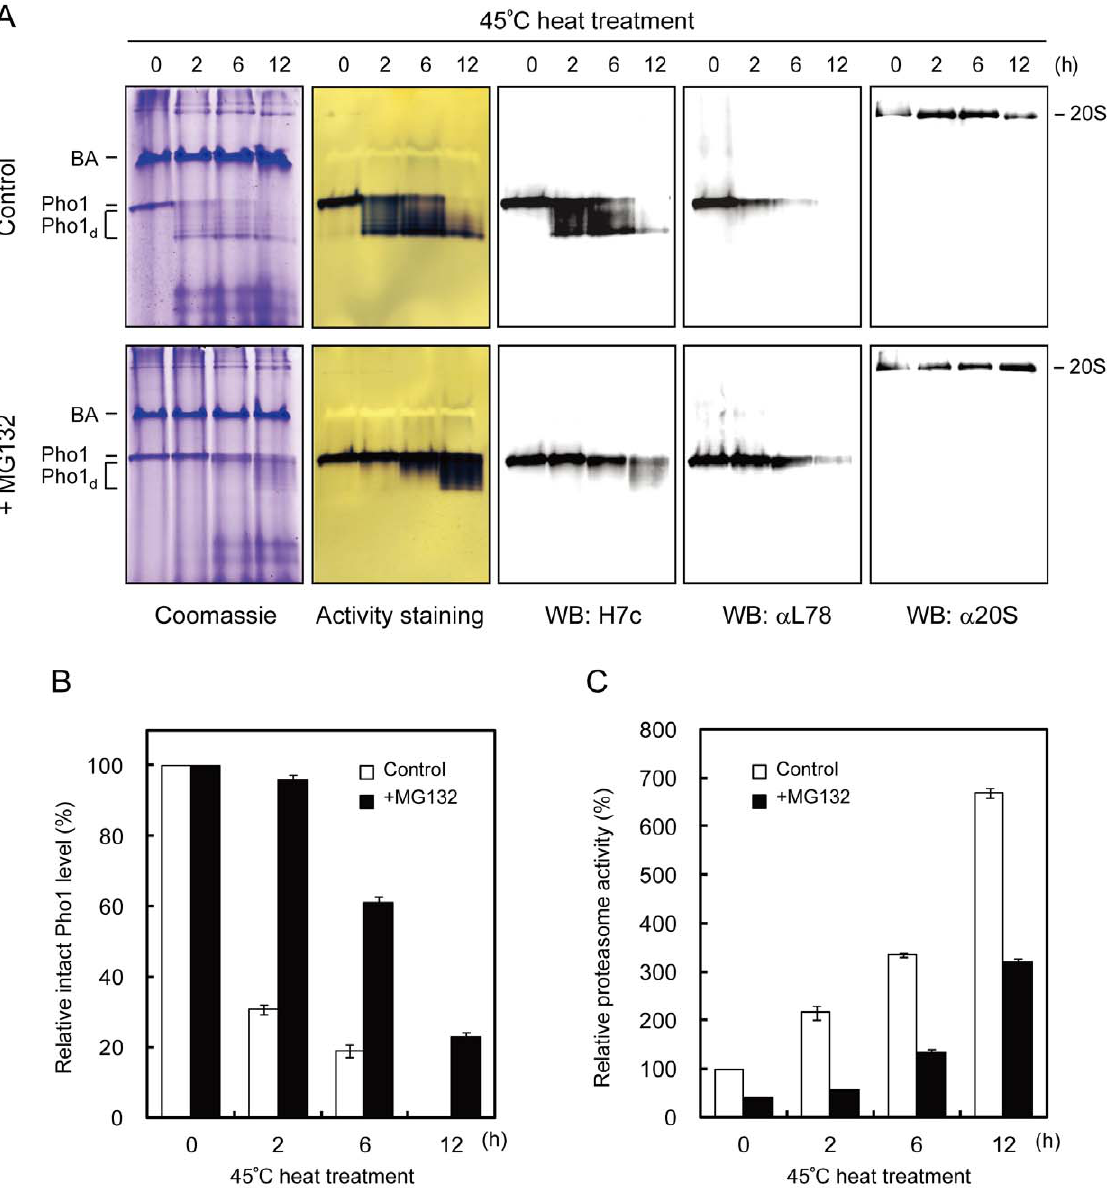
Figure 5. Heat treatment triggered the proteolytic modification of Pho1 by the 20S proteasome. In two parallel experiments sweet potato root discs (0.5 mm thick) were pretreated without (Control) or with 100 m M of MG132 ( + MG132), and then incubated at 45 u C for the indicated time periods. BA, beta amylase; Pho1, intact Pho1; Pho1 d , proteolytic modified Pho1. ( A ) The crude protein extracts of the discs (10 m g) were separated by 7.5% native PAGE and analyzed by Coomassie staining, Pho1 activity staining or western blotting with H7c, a L78 or a 20S antibody, respectively. Data are representative of three independent experiments. ( B ) Quantitative densitometry of the protein levels of intact Pho1 on the western blots detected by a L78 antibody in Figure 5A. The intact Pho1 level of the sample pretreated without (Control) or with MG132 ( + MG132) at time zero was expressed as 100%. Values are means 6 S.D. from three independent experiments. ( C ) The 20S proteasome activities in the samples pretreated without (Control, bars in white) or with MG132 ( + MG132, bars in black) were also determined by using Suc-LLVY-AMC as the substrate. The 20S proteasome activity in the control sample at time zero was expressed as 100%. Values are means 6 S.D. from three independent experiments.